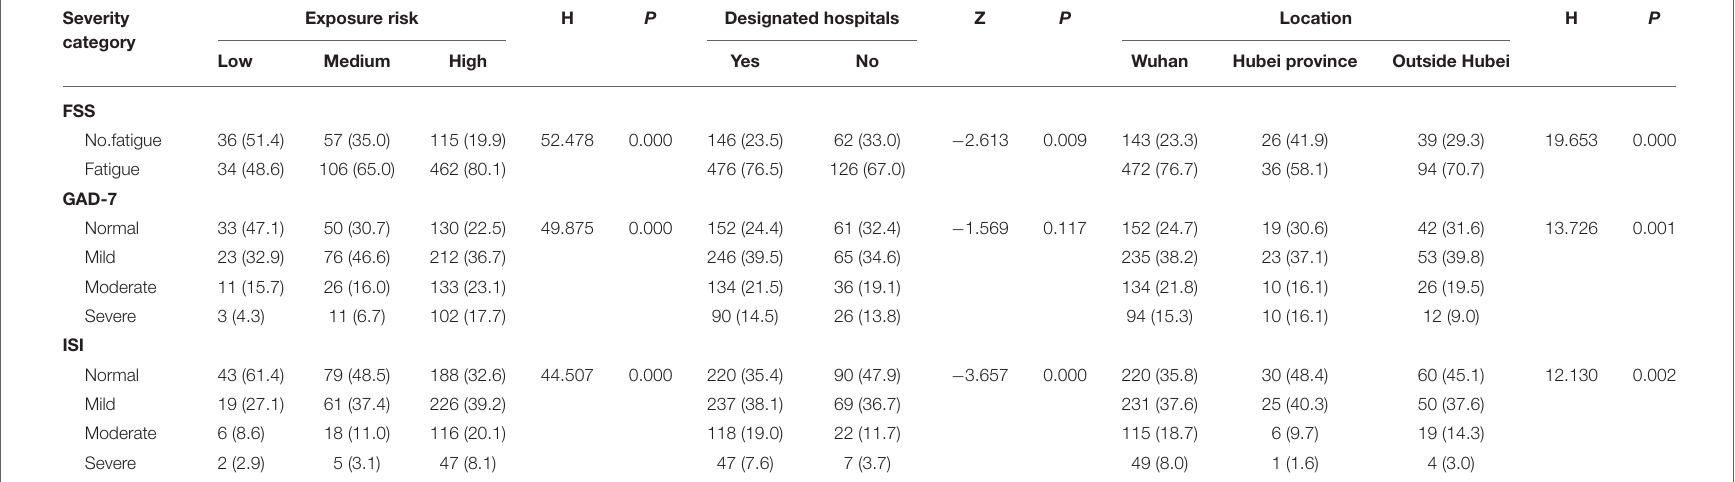
TABLE 2.2 | Severity Categories of Fatigue, Anxiety, and Insomnia Measurements in